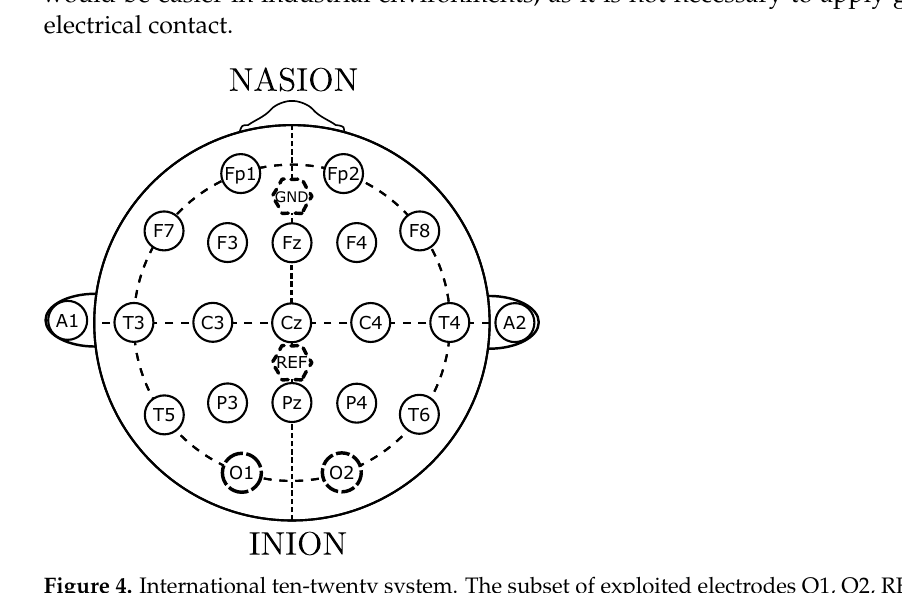
Figure 4. International ten-twenty system. The subset of exploited electrodes O1, O2, REF, and GND is highlighted with dashed bold